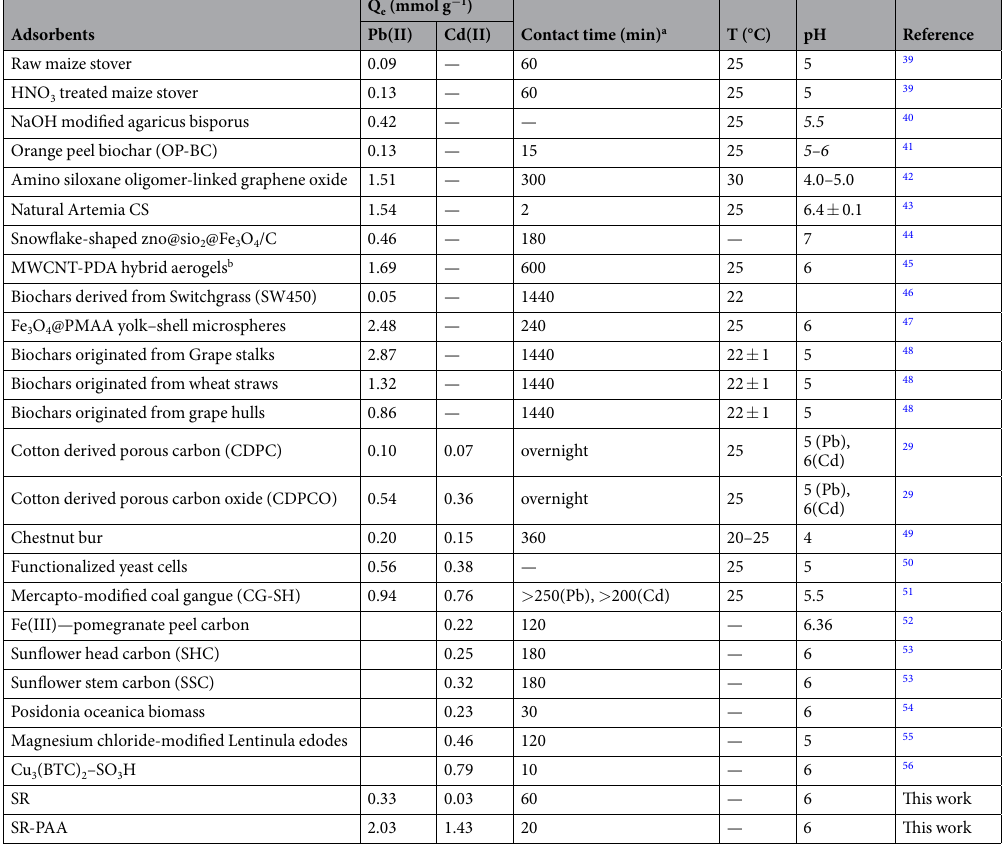
Table 1. Comparison of Pb(II) and Cd(II) ions adsorption capacity (mmol g − 1 ) on SR-PAA and